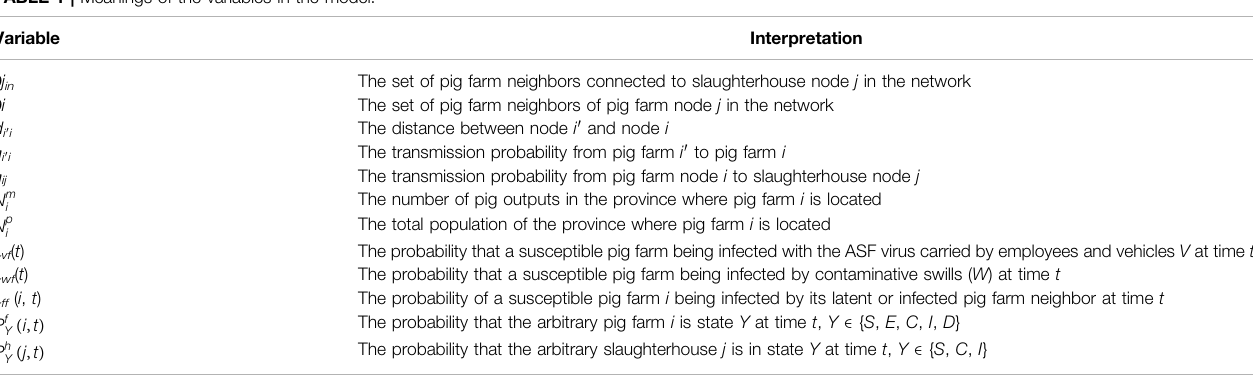
TABLE 1 | Meanings of the variables in the model.